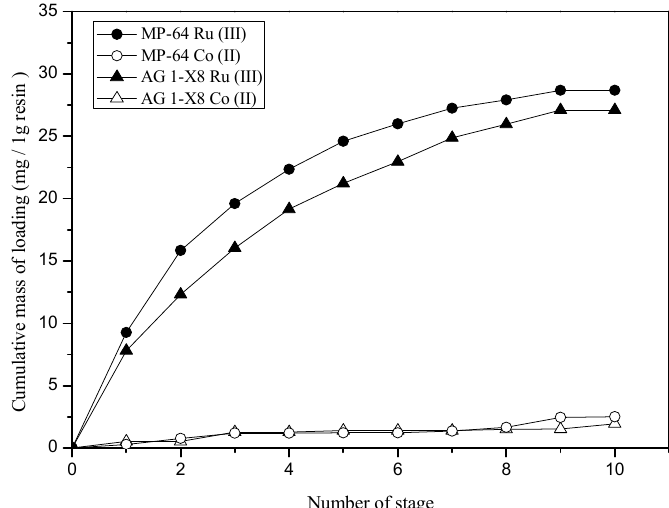
Figure 9. Determination of loading capacity of AG 1-X8 and Lewatit MP-64 resins for Ru(III). ([Time] = 6 h, [Resin] = 0.5 g/L, [Co(II)] = 100 mg/L and [Ru(III)] = 10 mg/L).